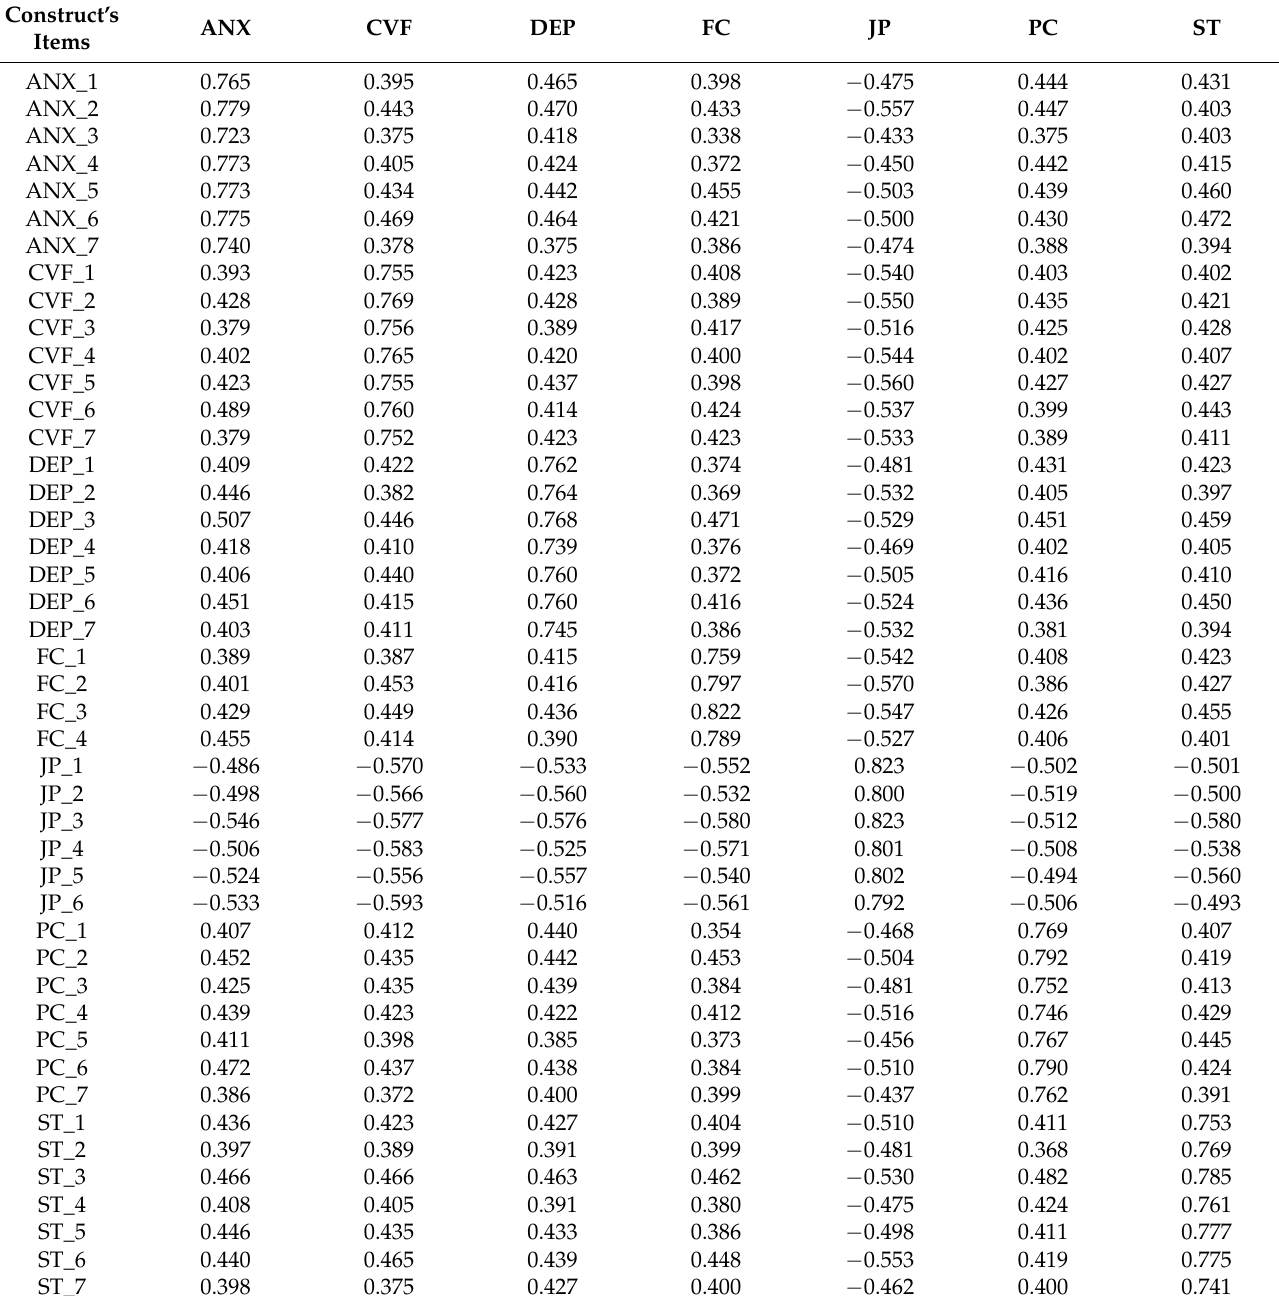
Table 6. Discriminant Validity Analysis